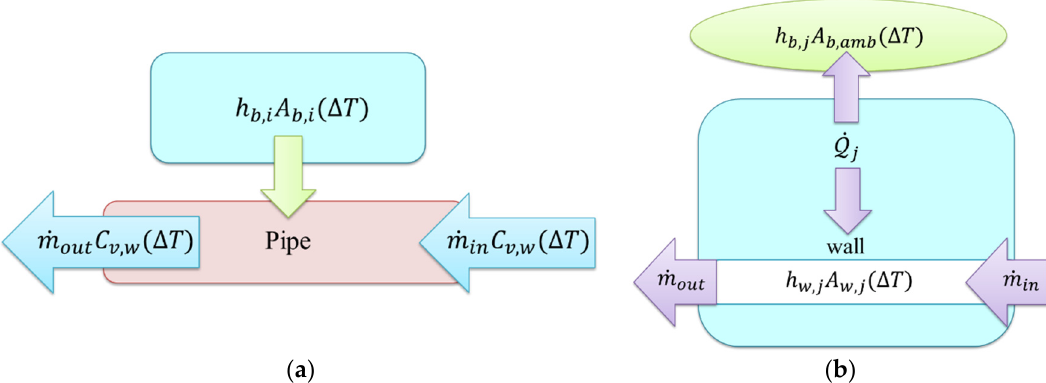
Figure 2. Heat and temperature variation of a control volume: ( a ) coolant pipe, ( b ) body.